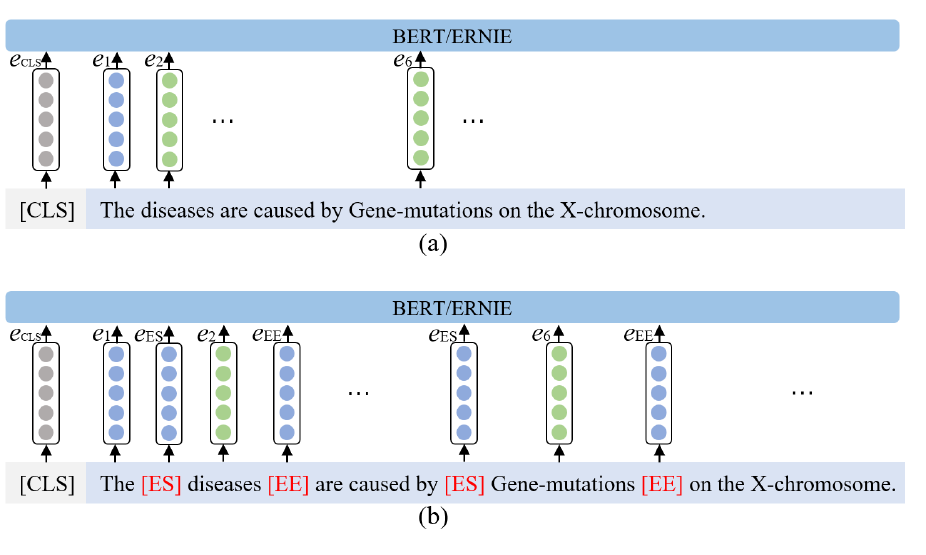
Figure 3. The difference between the common input sequence and the enhanced input sequence with entity markers. ( a ) The common input sequence. ( b ) The enhanced input sequence with entity